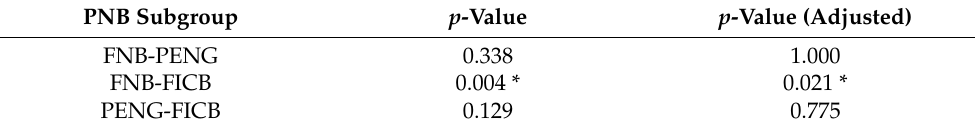
Table 5. Subgroup analysis of VAS among the PNB groups, 24–48 h postoperatively during activity. PNB